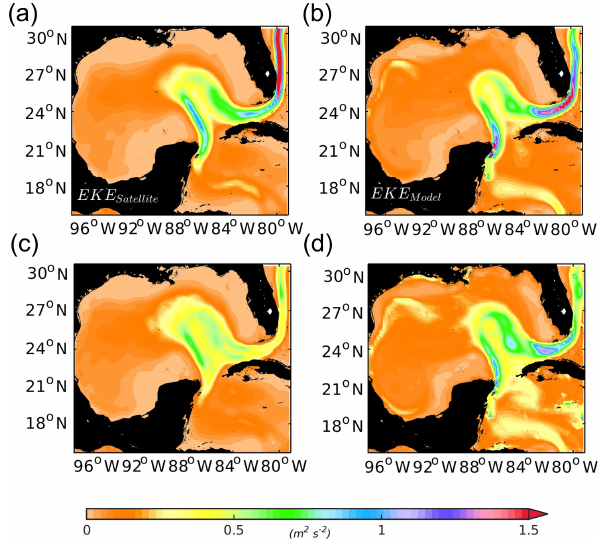
Figure A1. Comparison of 17-year (1995–2012) averaged eddy kinetic energy (EKE, m 2 s − 2 ) calculated based on (a) AVISO SSH product and (b) ROMS model simulated SSH. Panels (c) and (d) show the standard deviation for altimeter and model EKE, respectively.